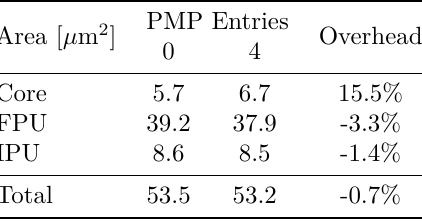
Table 2: The area rundown of the accelerator with 0 and 4 PMP entries respectively. Synthesized in 22nm with 750MHz clock for 0 entries and 666MHz with 4